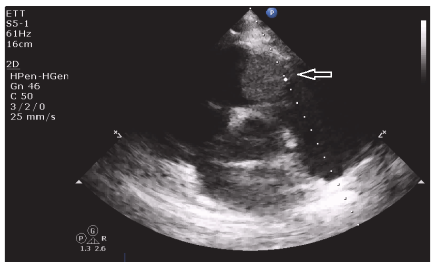
Figure 1: TTE revealing the mass on the pulmonary valve.